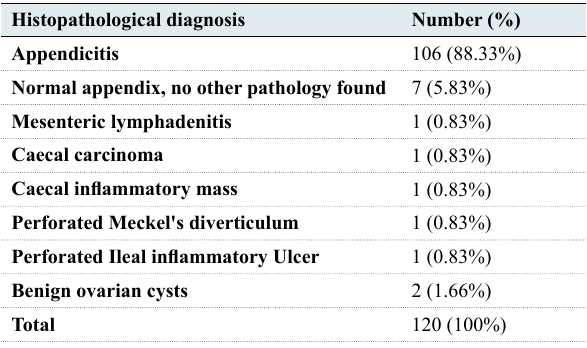
Table 2: Modified RIPASA scoring system